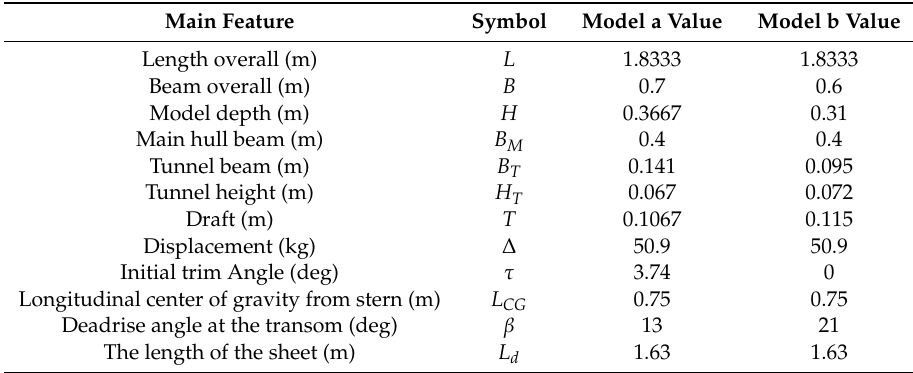
Table 6. The di ff erence in hull parameters between Model a and Model